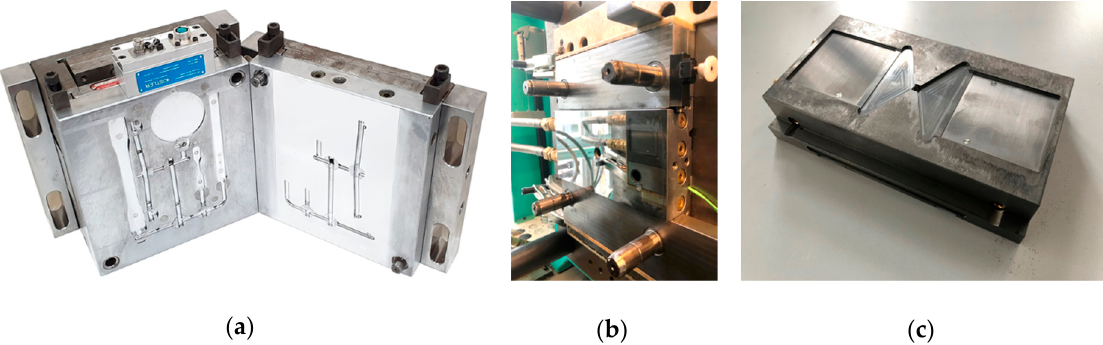
Figure 2. Injection molds: ( a ) mold type A, ( b ) fixed plate of the mold type B, and ( c ) moving plate of mold type B